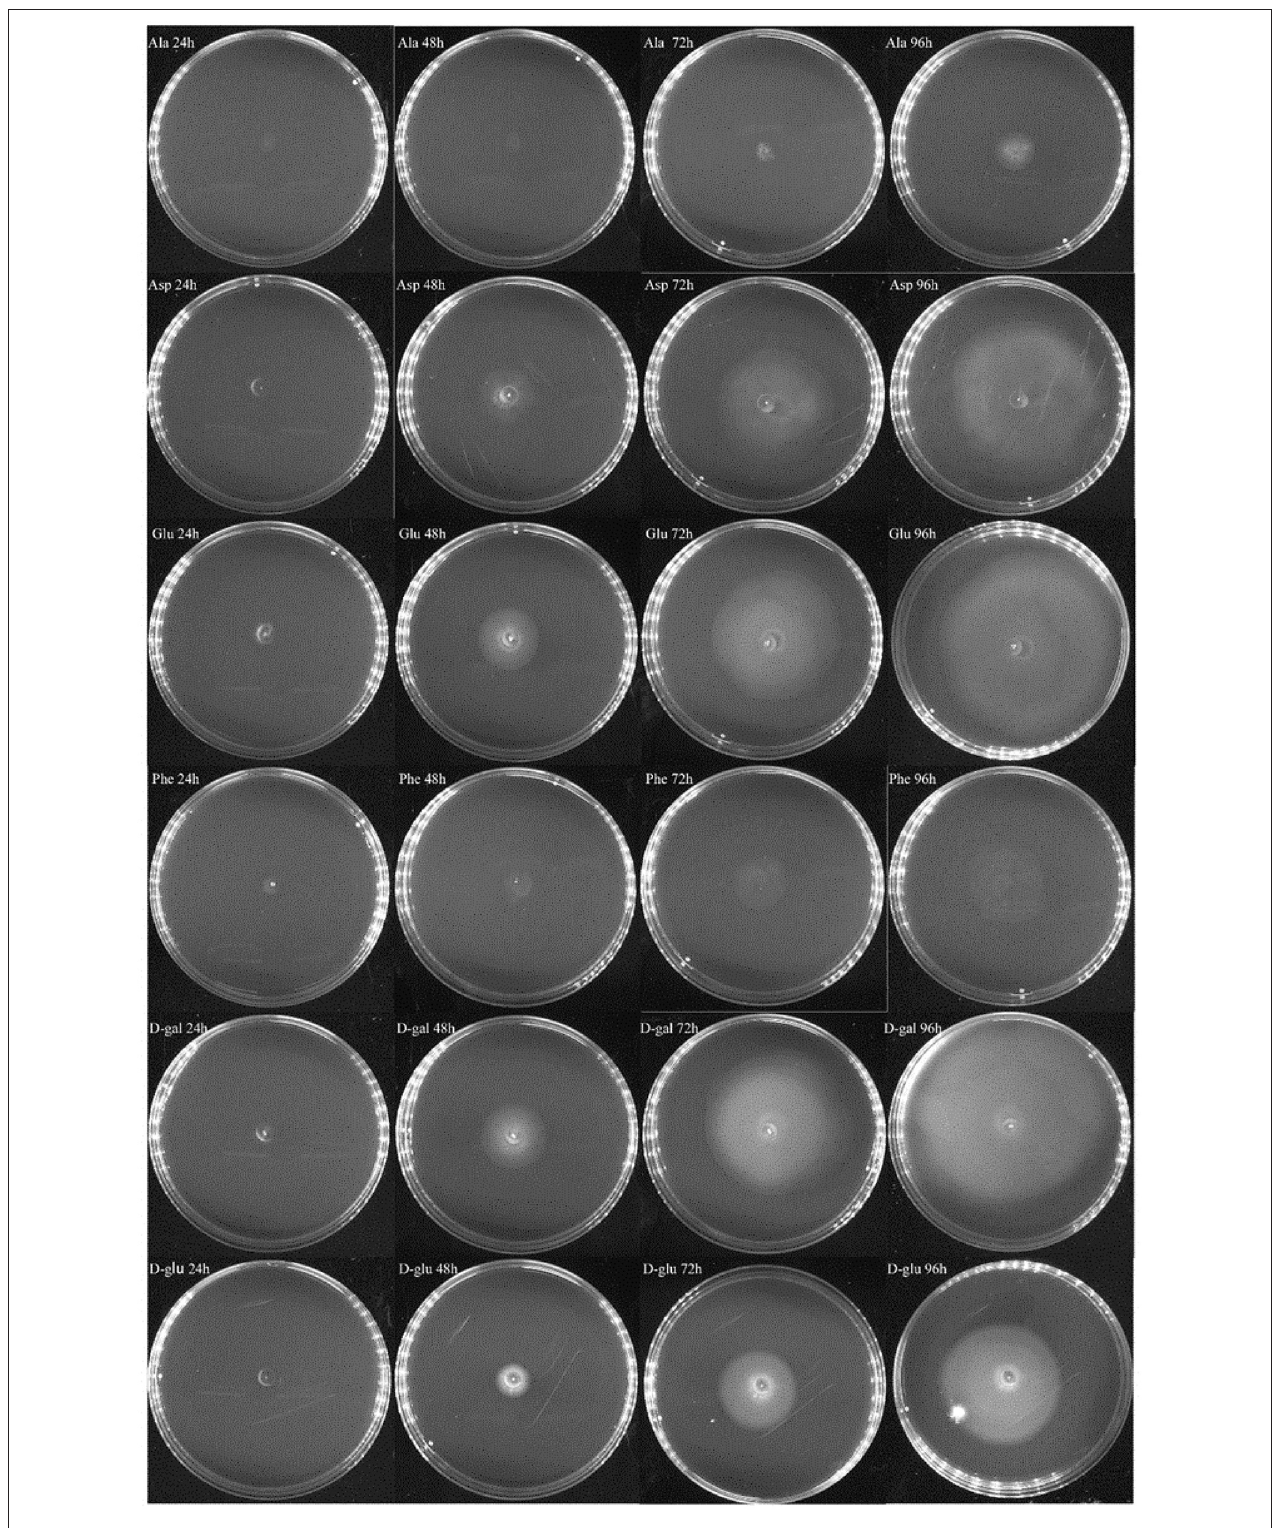
FIGURE 7 | Chemotaxis of the regrown cells of V. splendidus persister cells. Each exogenous carbon source at a concentration of 400 mg · L − 1 was separately added into M9 minimal plates containing 0.20% (w/v) agar; 1ml M9 minimal medium was used to resuspend persister cells, and 10 µ l bacterial suspension was dropped on M9 plate containing each carbon source, and the plates were incubated at 28 ◦ C for 96h.